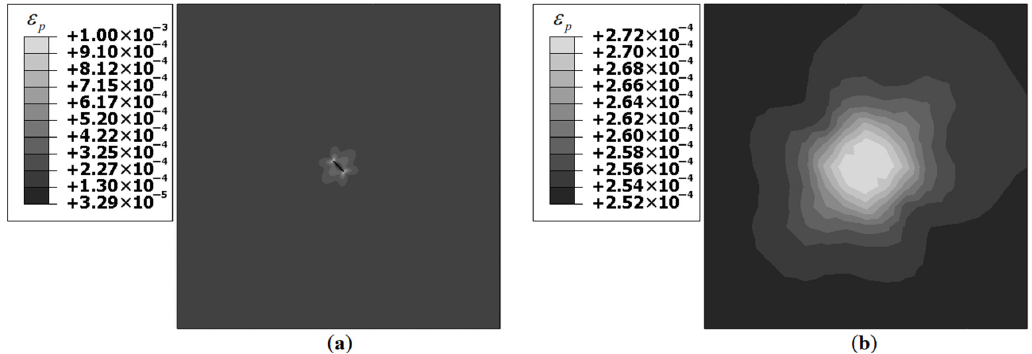
Figure 7. Contour plots of 𝜀 (cid:3043) for Damage Case-3: ( a ) FE results, and ( b ) benchmark iFEM